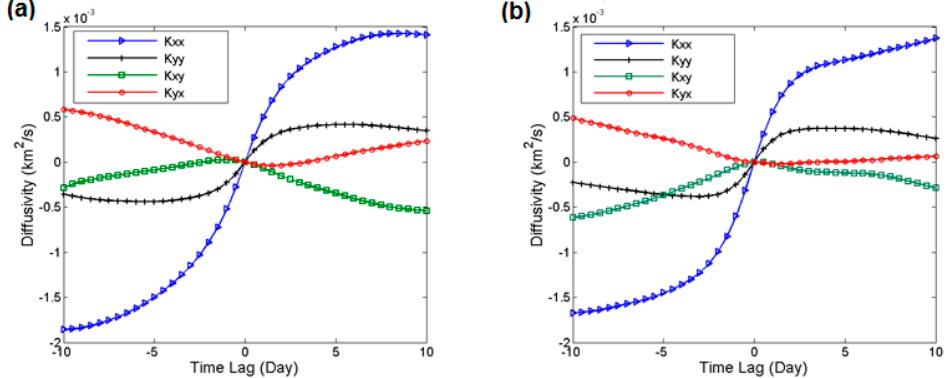
6 Figure 9. Lagrangian statistic (velocity covariance) calculated for the entire Adriatic basin after removal of the mean Eulerian circulation. Statistics are shown versus time lags ranging between − 10 and 10 days for numerical particles in 2007 ( a ) and 2008 ( b ). (Pxx and Pyy show along and across basin velocity covariance values respectively). Lagrangian statistics, calculated using the residual velocities, have a limitation related to the